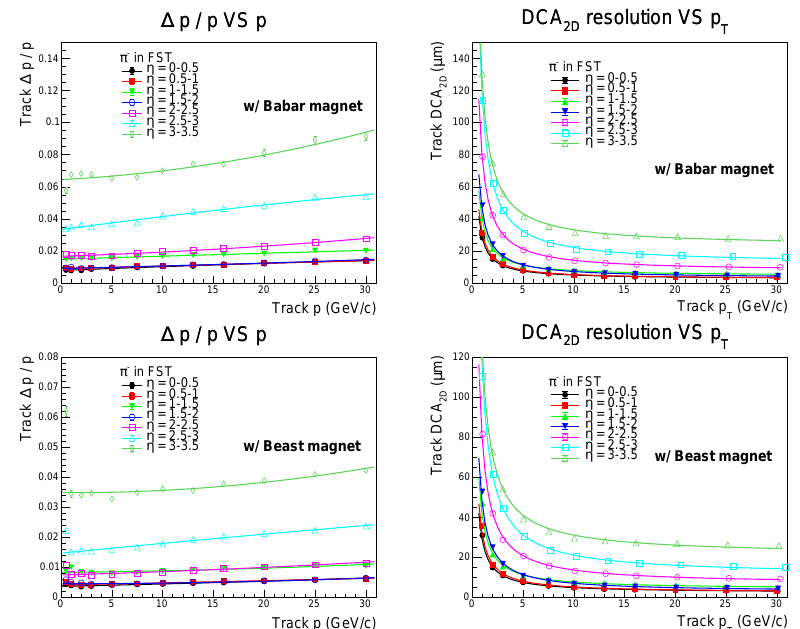
Figure 1: Performances of an integrated silicon tracking system with the Babar mag- net for the future EIC [ 2 ] are shown in the top and the results with the Beast magnet are shown in the bottom. The track momentum resolutions versus track momentum in different pseudorapidities are shown in the left and the pseudorapidity dependent track transverse distance of closet approach (DCA ) resolutions versus transverse 2 D momentum are illustrated in the